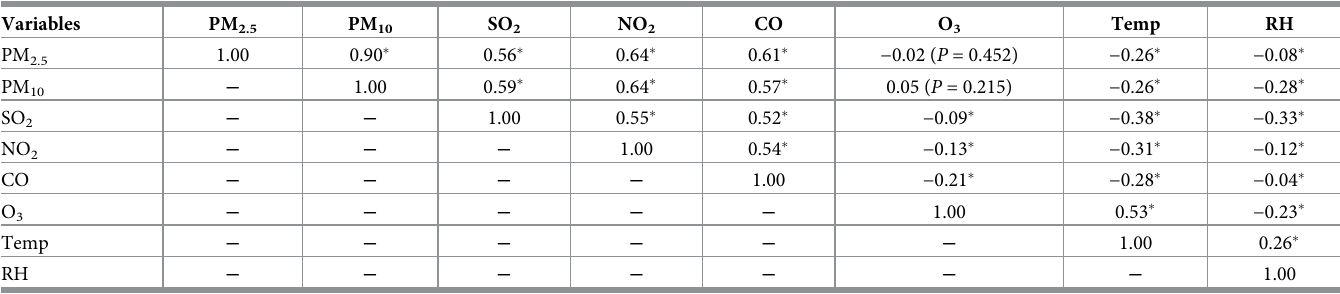
Table 2. Spearman correlation coefficients among the environmental variables in 184 Chinese cities, 2014–2017.